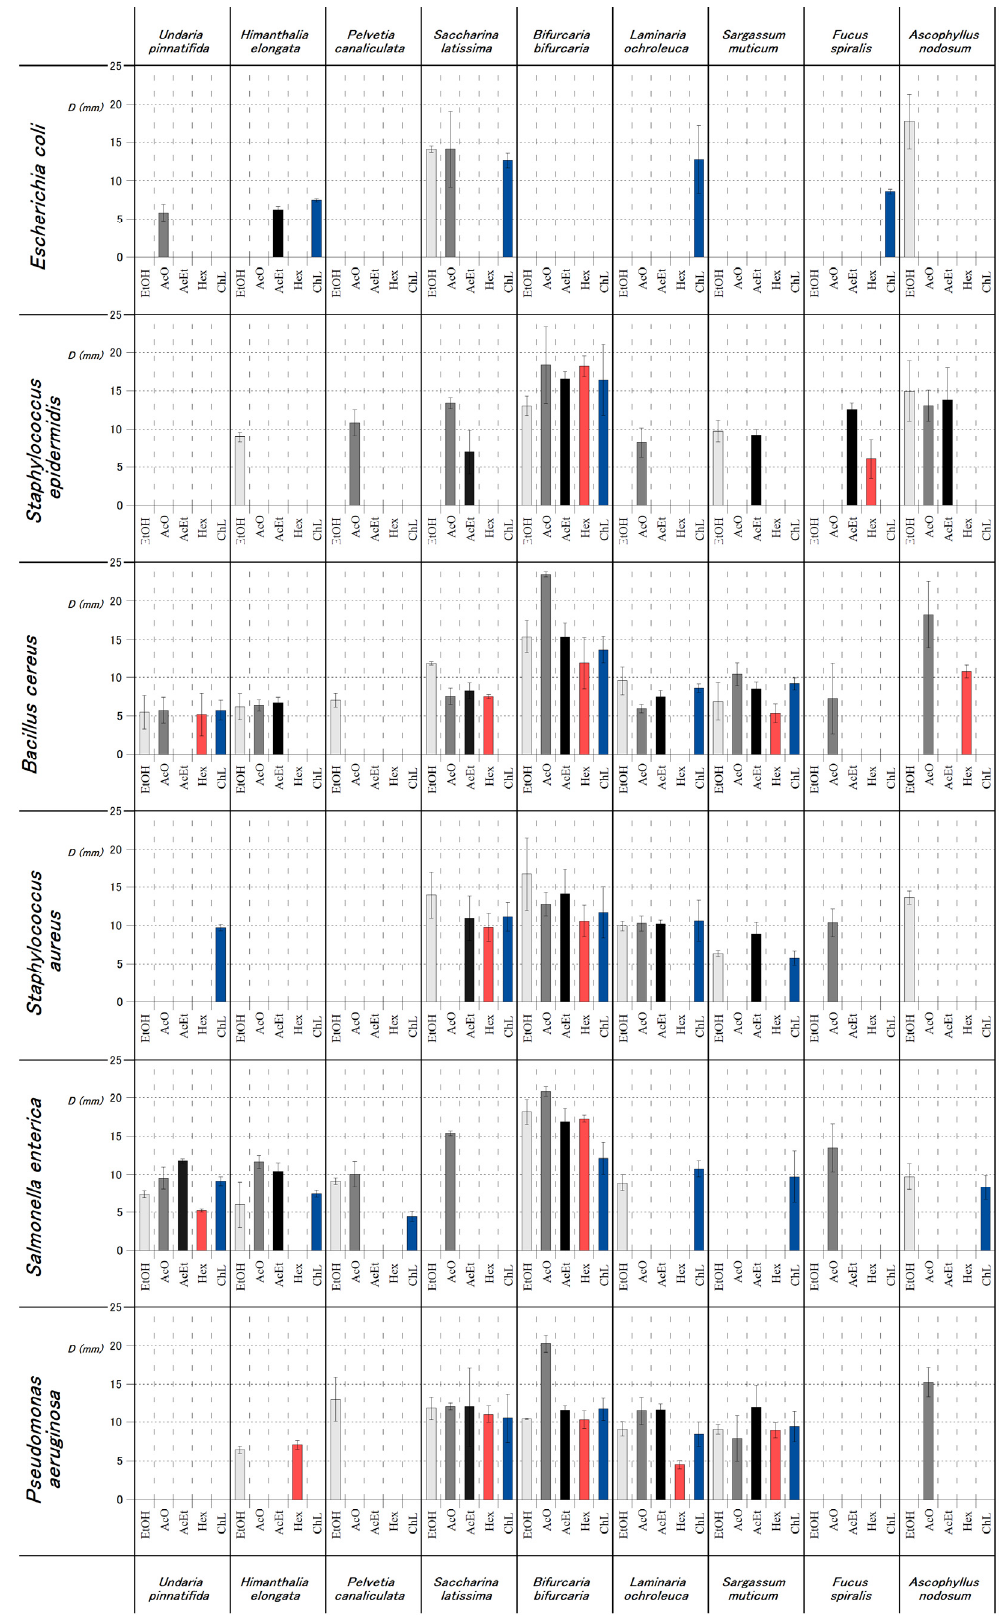
Figure 2. Diameter values (D, mm) for the inhibition growth values reported for the antimicrobial activity of brown algae extracts. Vertical bars show standard deviation of three replicates.